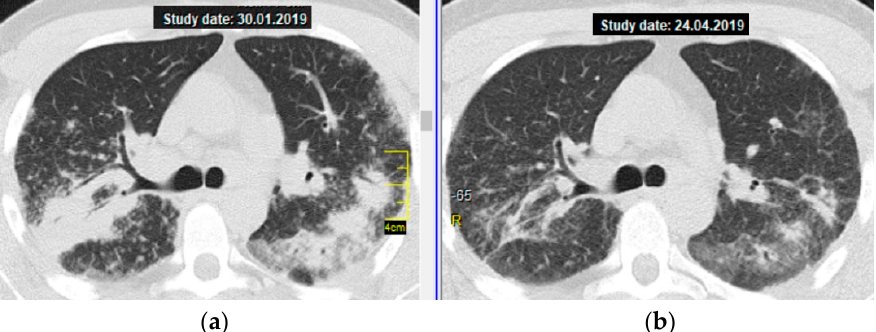
Figure 1. Pulmonary sarcoidosis, stage II, atypical form—multiple massive consolidations in both lungs; a thoracic CT scan (axial section at the level of the tracheal bifurcation): ( a ) on the left—before treatment, ( b ) on the right—regression after 3 months of MTX therapy (15 mg/week).